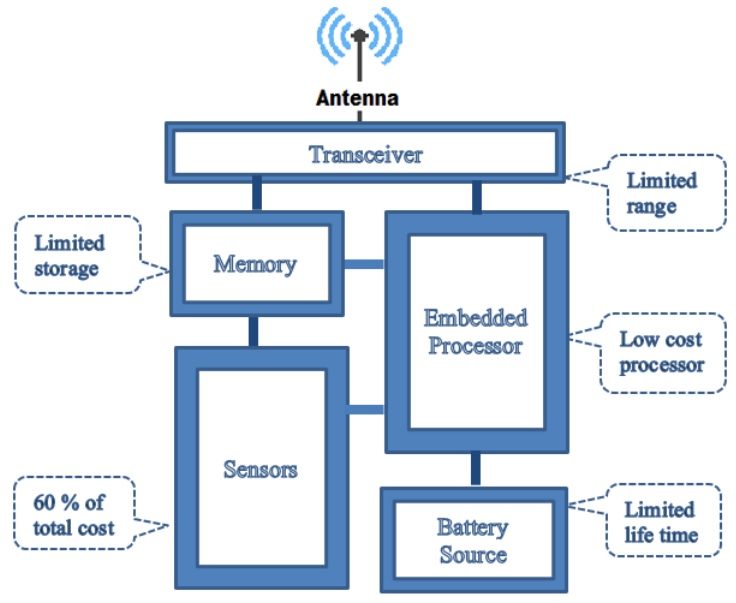
Figure 1. Typical sensor node block